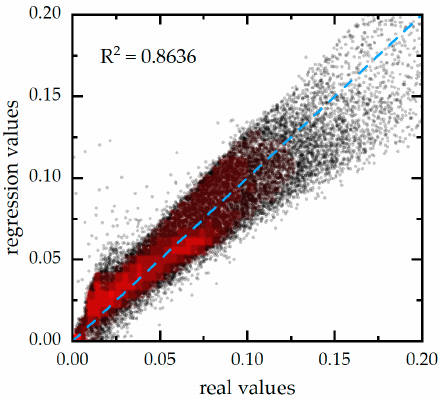
Figure 4. The scatterplot of the regression values versus the real values of the reflectance of snow cover in the SWIR band.